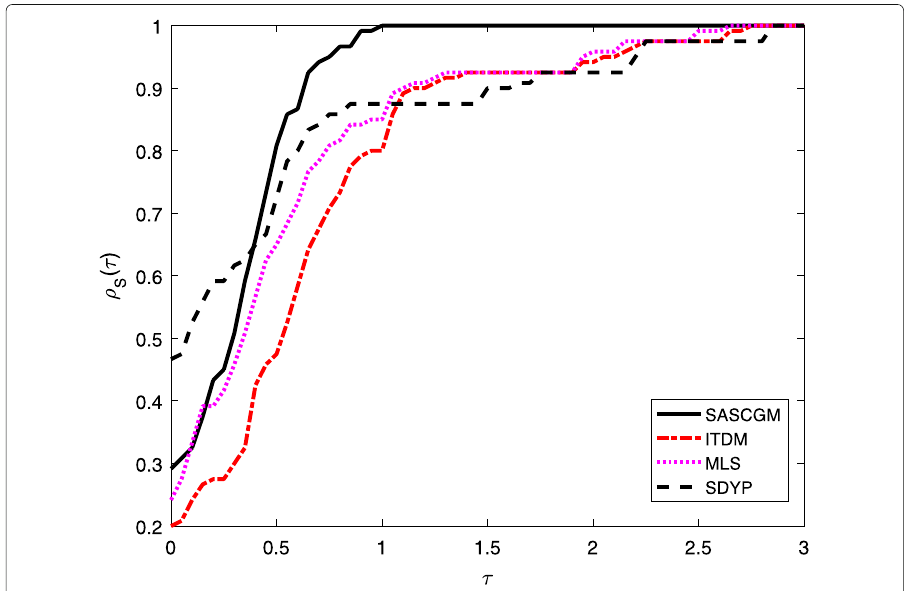
Fig. 2 Function evaluations performance